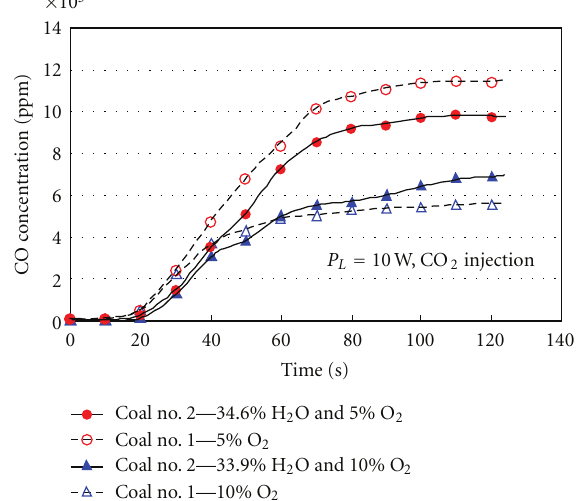
Figure 13: Comparisons of coal and coal water mixture on CO gas generation by CO 2 injection.